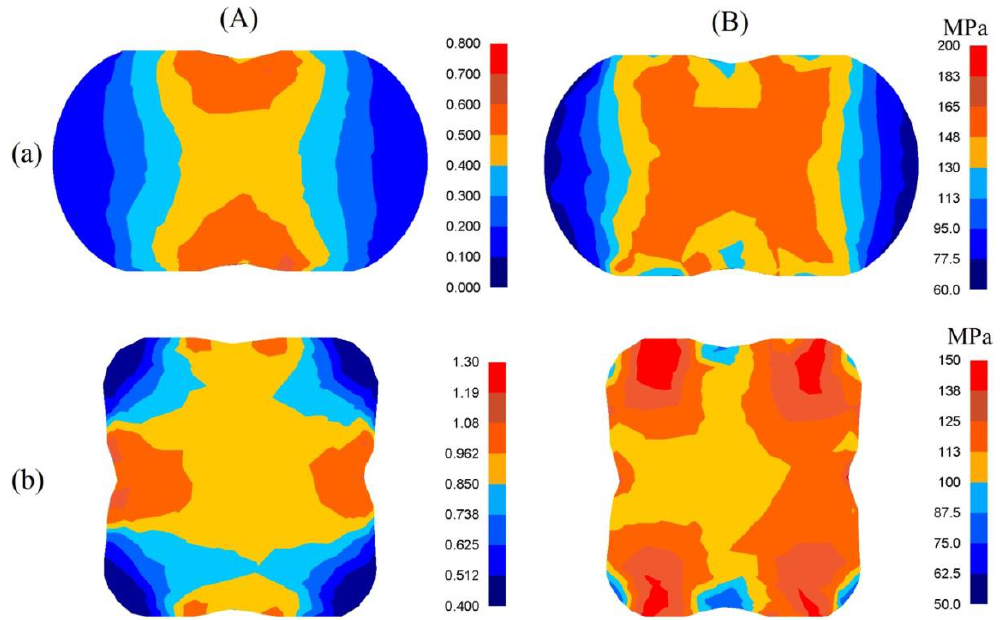
Figure 5. Distribution of effective strain ( A ) and effective stress ( B ) after the cogging process in convex anvils with an angle of 130°: ( a ) after first pass; ( b ) after the second pass (reduction ratio 0.70) .